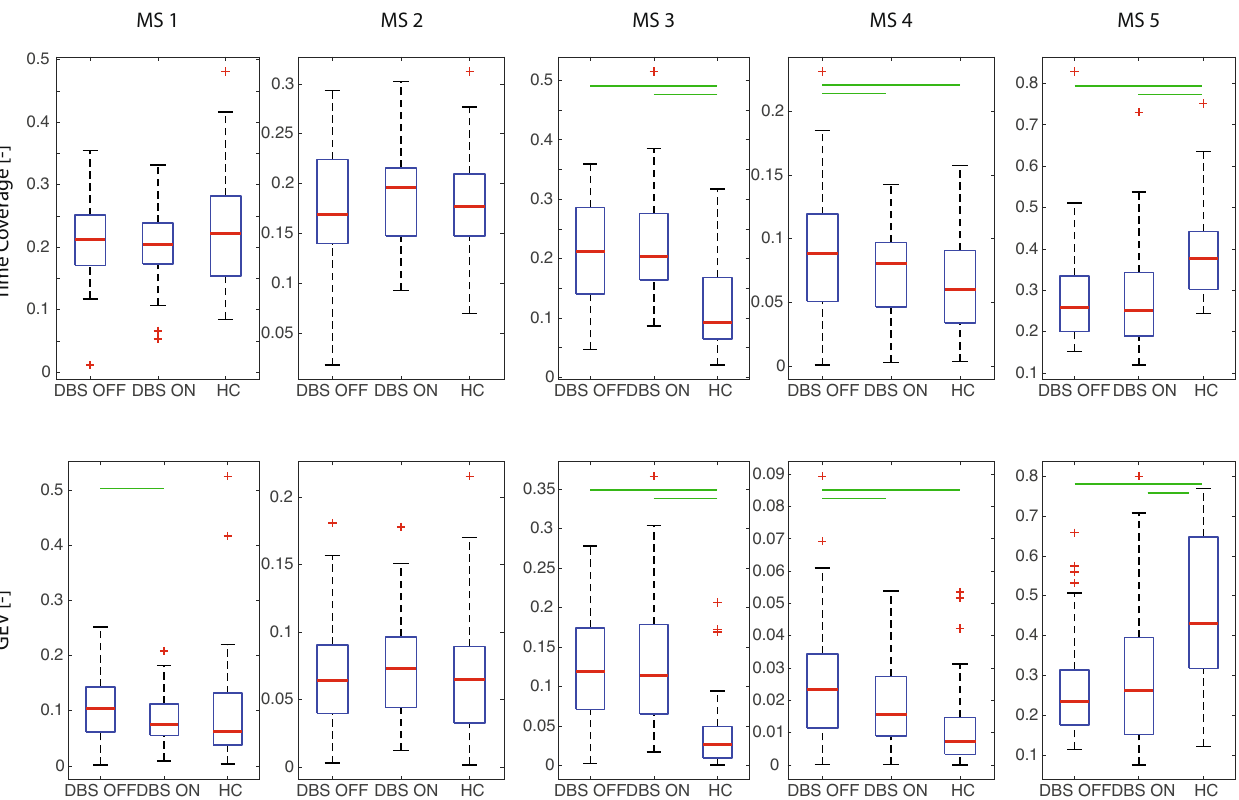
Fig. 2 Comparison of temporal parameters (time coverage top, GEV bottom) of fi ve identi fi ed microstates in each analyzed group. Each box covers the data from 25th to 75th percentiles; the red line in each box represents the median over subjects in a particular group, and whiskers represent 1.5 times the interquartile range (IQR). Red crosses show the outliers. Green lines mark signi fi cant differences ( p < 0.05